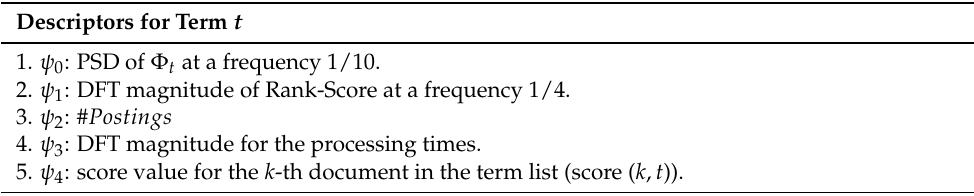
Table 2. Term-vector and query-vector